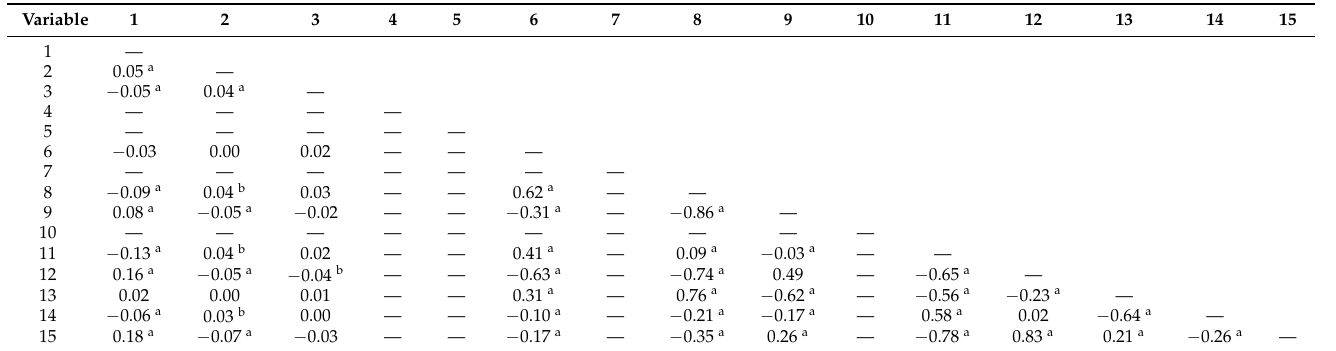
Table 8. Correlation of measured speed with road factors (70 mph